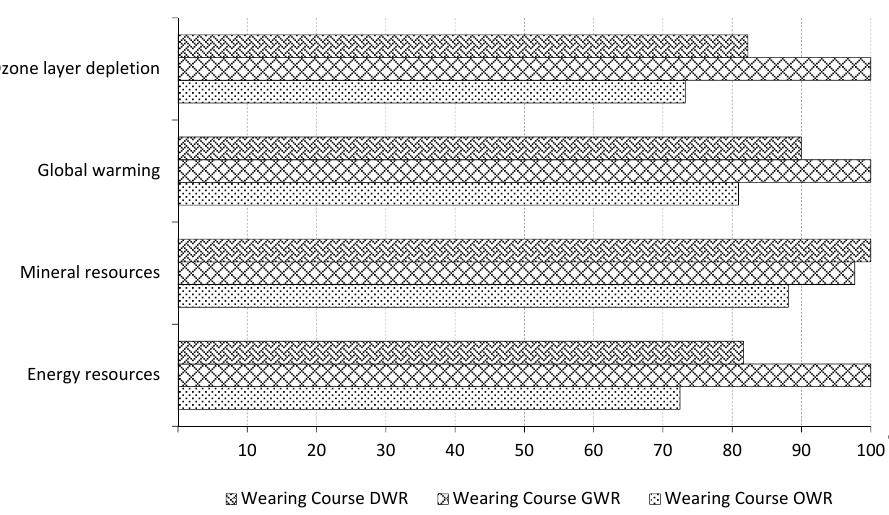
Figure 8. Comparison between wet rubberized wearing courses.